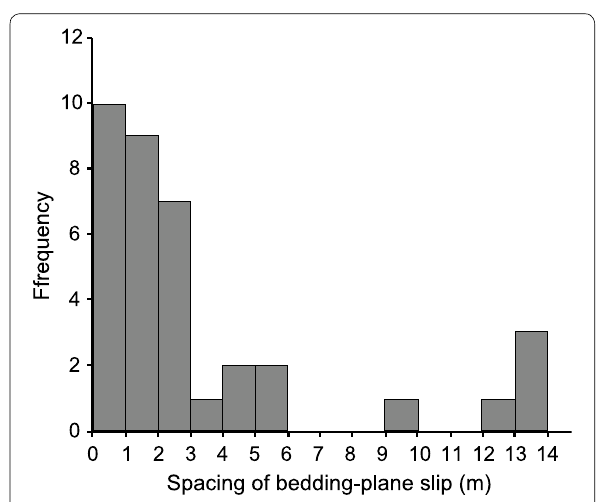
Fig. 3 Histogram showing the frequency distribution of the spacing of bedding-plane slip at the Katagai site